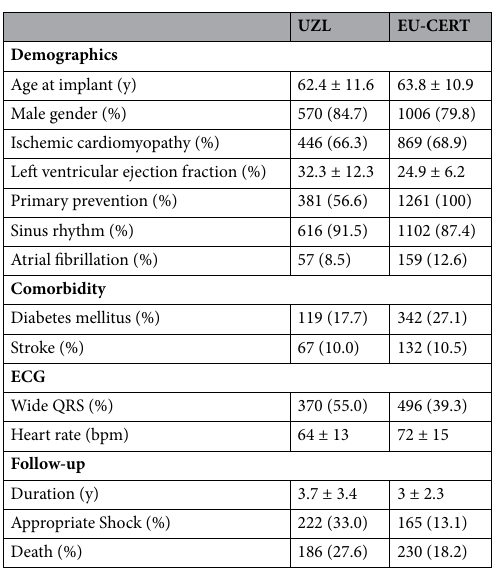
Table 1. Patient characterization for UZL and EU-CERT datasets. Expressed as number of ECG recordings and percentage between brackets, or mean ± standard deviation.